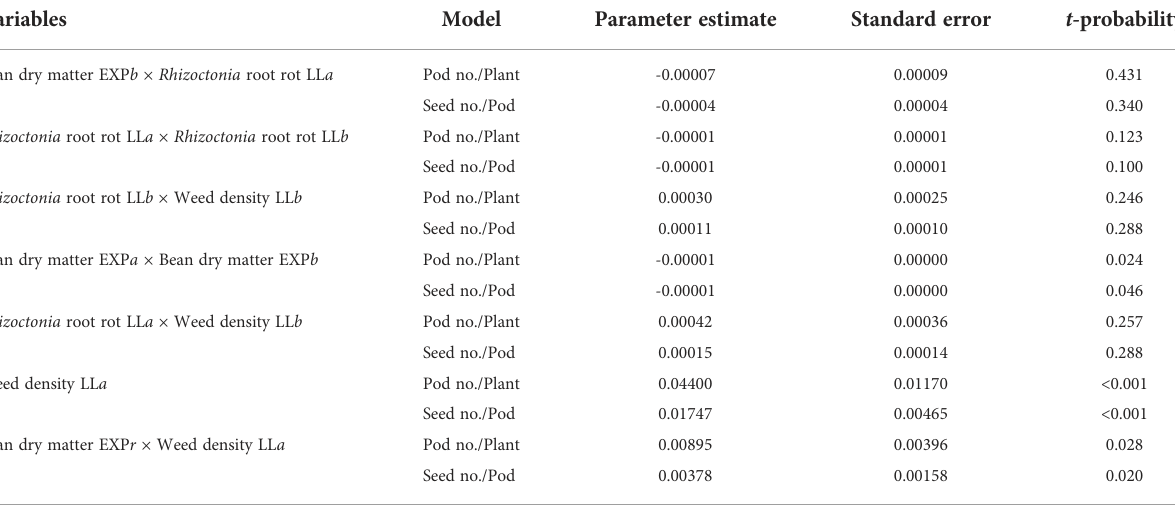
TABLE 6 Multivariate regression analysis of pod and seed production based on principal component analysis of bean growth, Rhizoctonia root rot, and weed descriptors in two cultivars sown under different dates and weed control treatments.